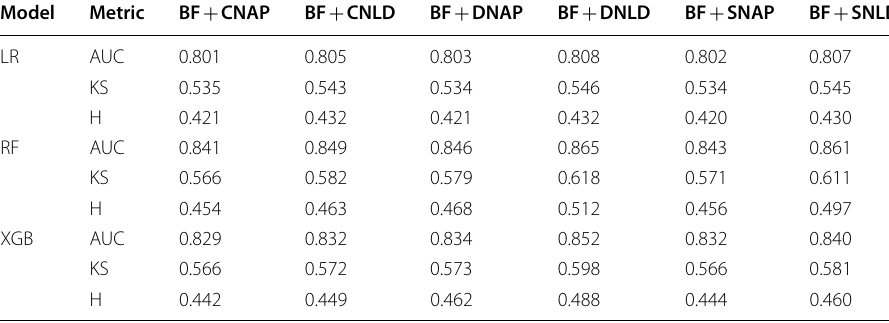
Each metric is measured by the mean of 100 estimates obtained by repeating the outer ten-fold cross-validation procedure ten times